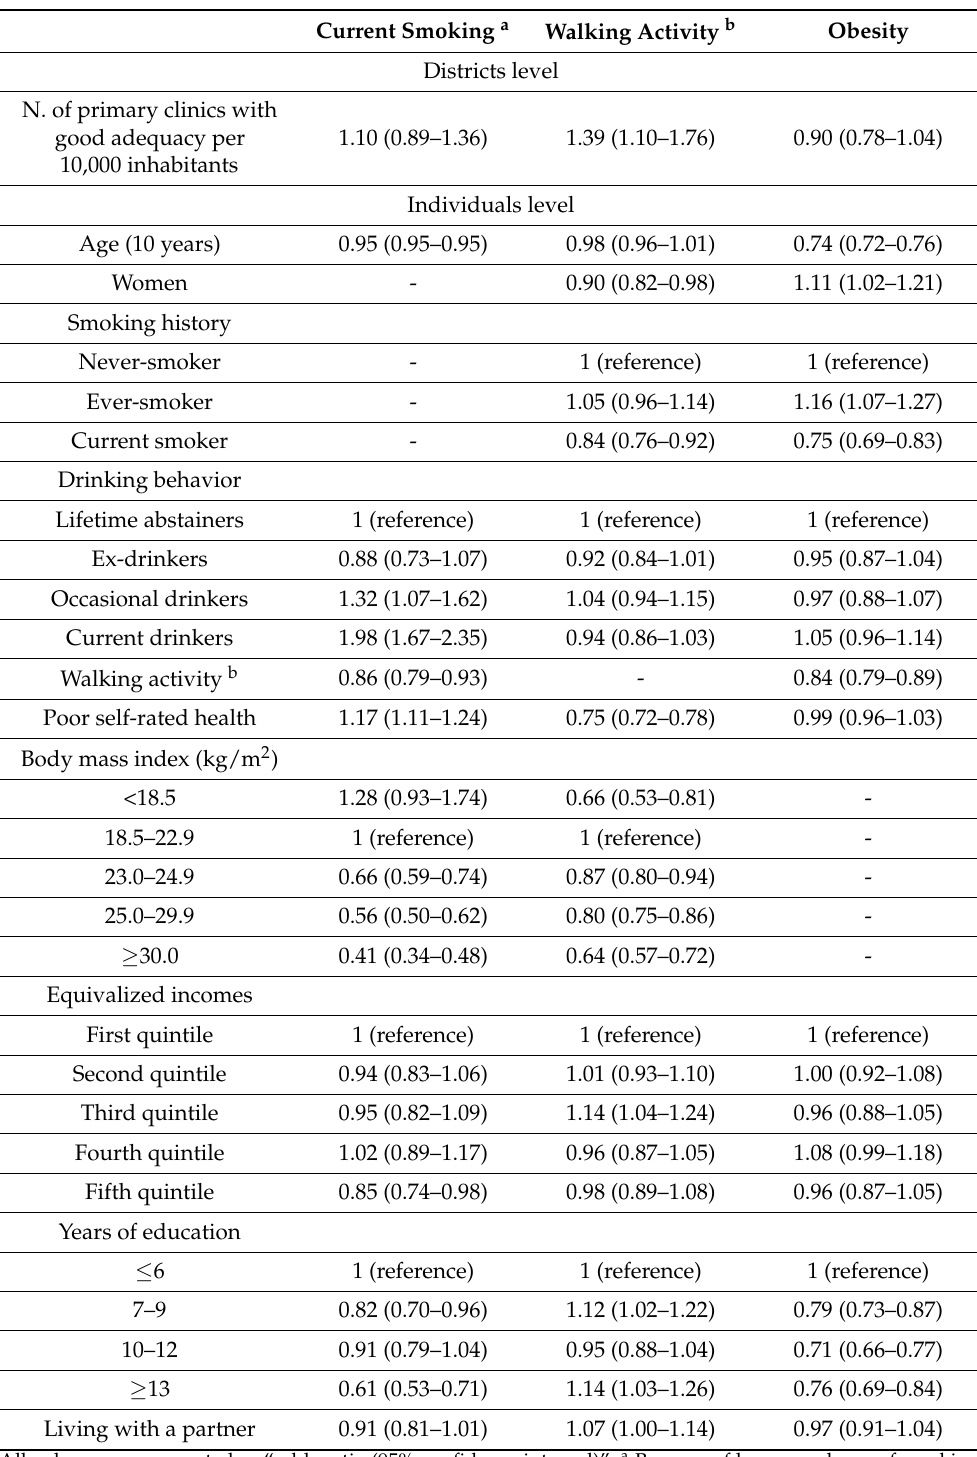
Table 2. Multilevel multivariate logistic regression for lifestyles in diabetes